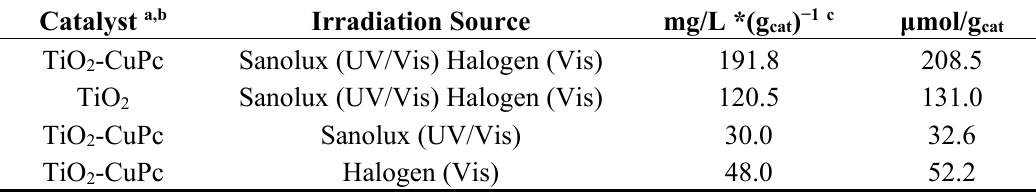
Table 4. Effect of irradiation sources on formic acid production efficiency at pH =